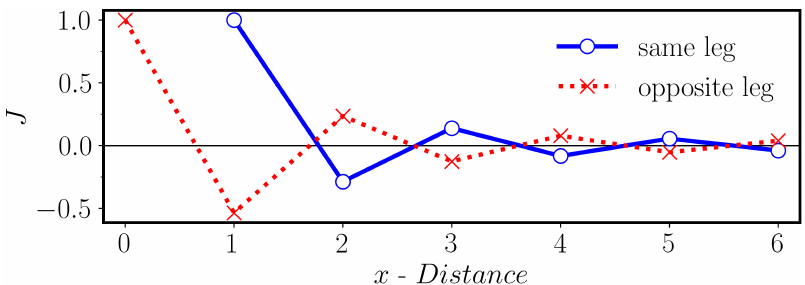
Figure 1: Exchange interaction between two spins at distance x along the same and opposite leg, for a value of α =